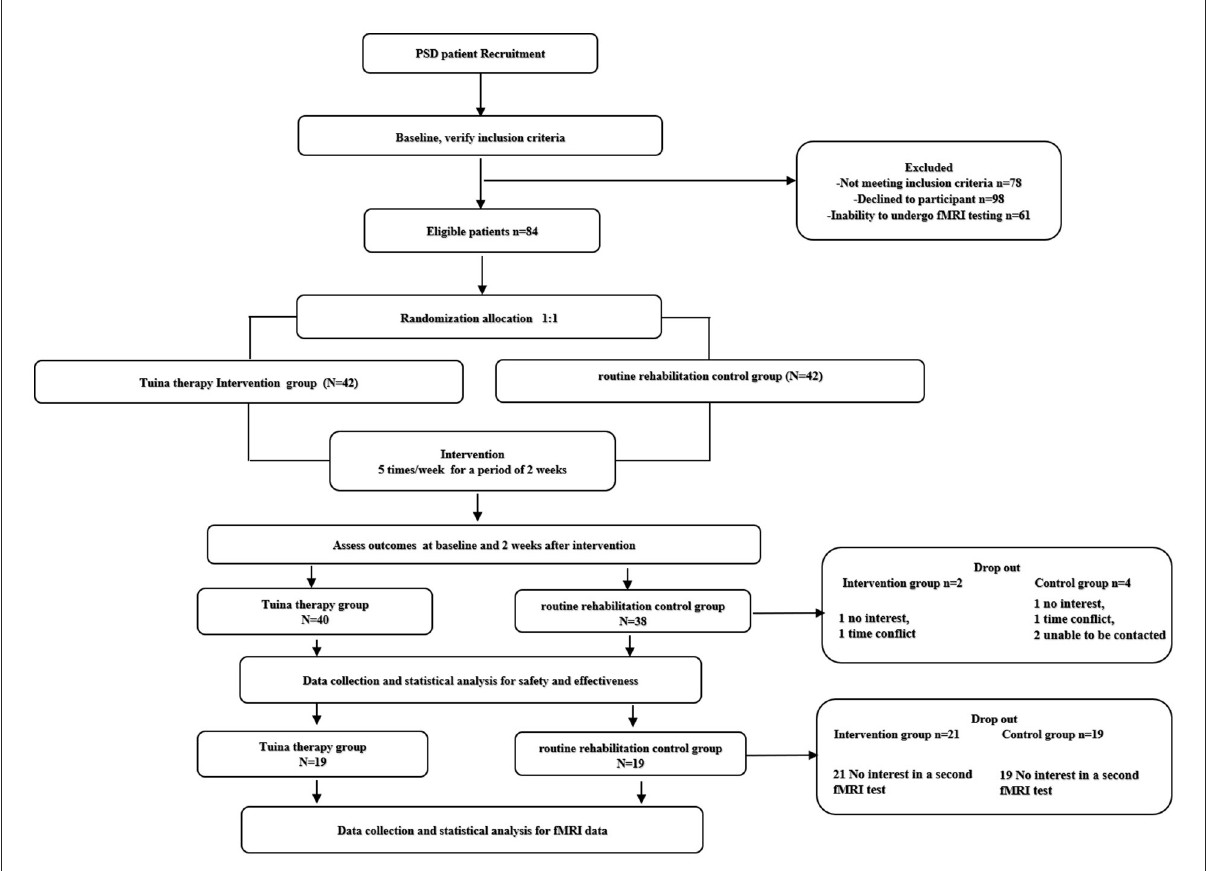
FIGURE1 Flow chart of the